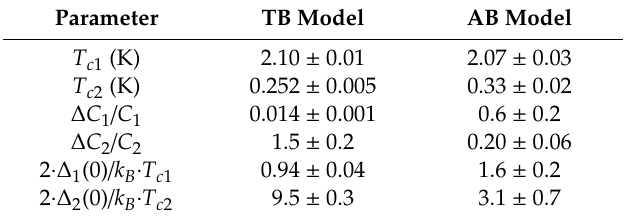
Table 4. Deduced parameters for for Nb / BiSbTeSe 2 -nanoribbon / Nb junction (Sample 1 [56]) at V g = 0 V from fit to two-band Titov and Beenakker (TB) [53] and Ambegaokar and Barato ff (AB) [7,8] models.